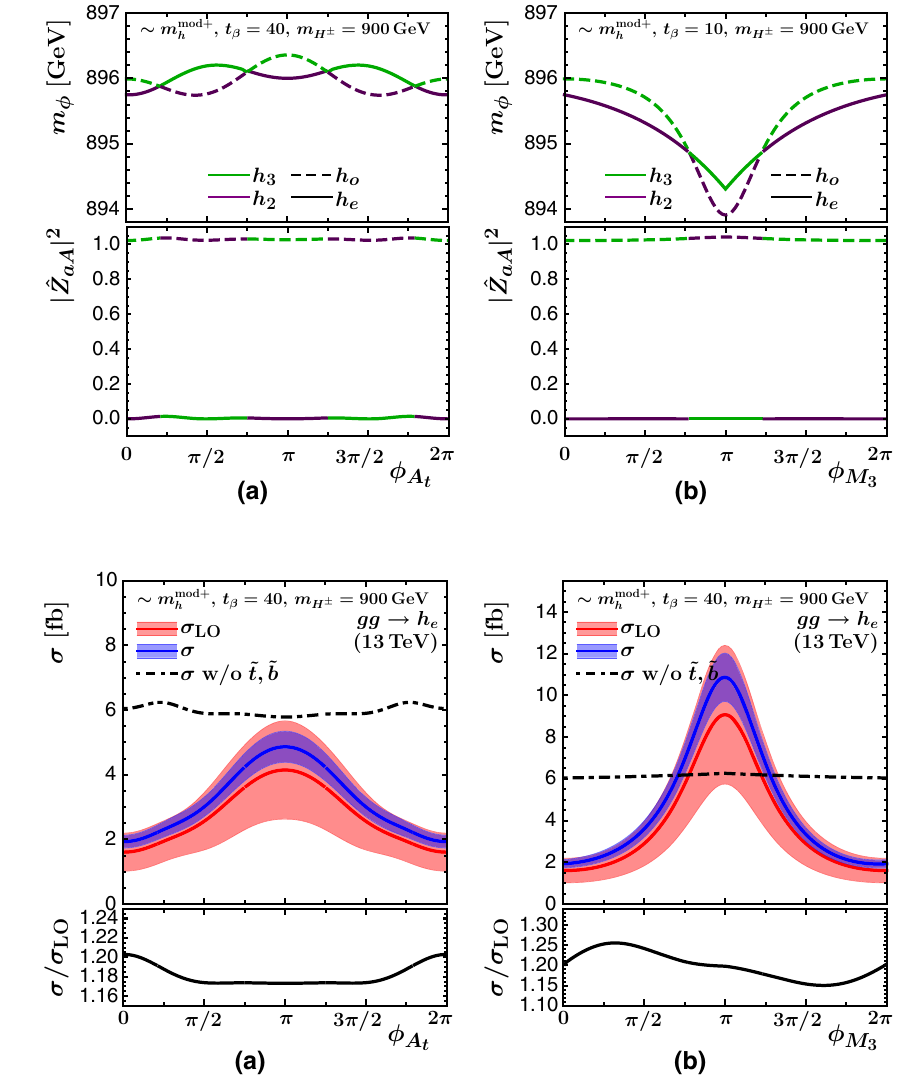
Fig. 7 Masses of h 2 and h 3 in GeV and CP -odd character as a function of a φ A and b φ M in t 3 the m mod + h the solid and dashed curves